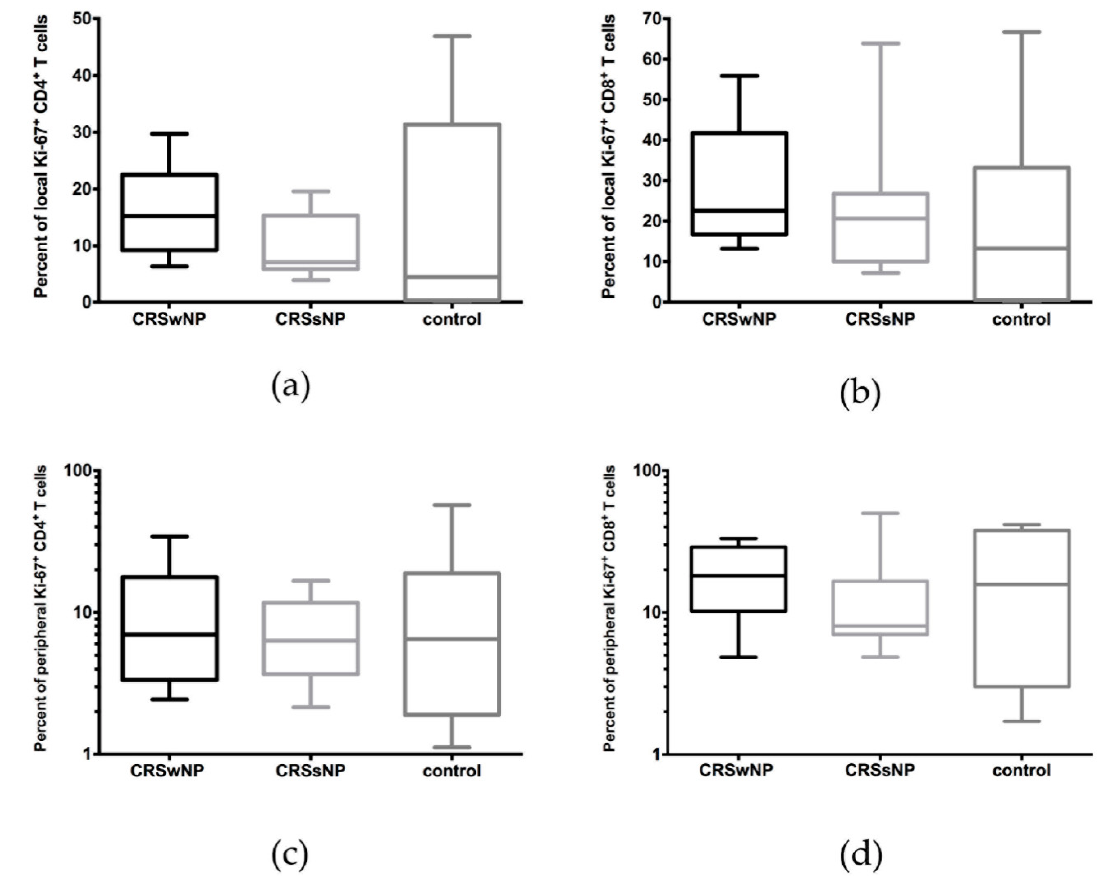
Figure 2. Comparison of ( a , b ) local and ( c , d ) peripheral CD4+ and CD8+ T cells among the patients with CRwNP, CRSsNP, and healthy controls, after stimulation with a peptide pool of C. albicans over 6 days. No significant differences were ob- served.